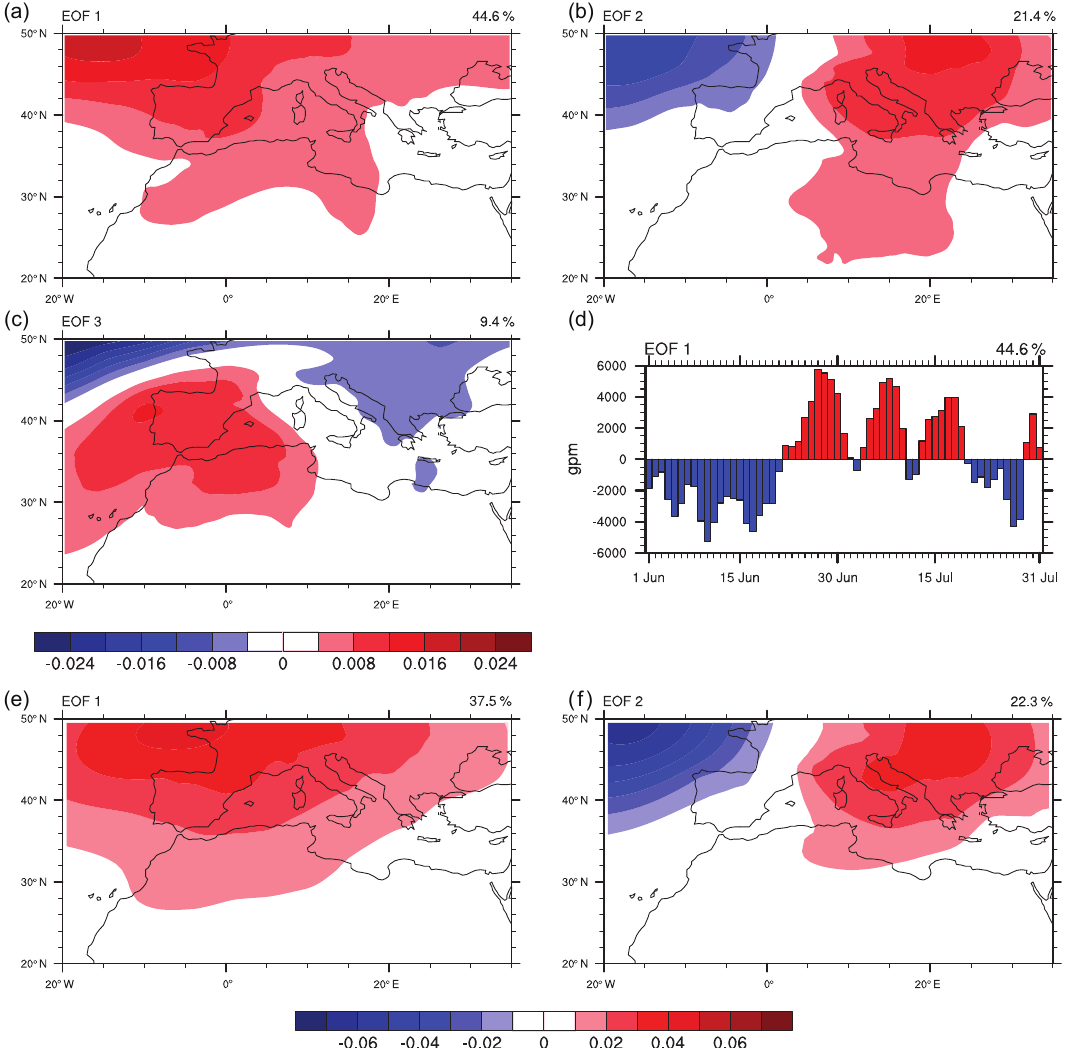
Figure 4. EOF analysis of the 00:00UTC geopotential height at 850hPa taken from COSMO-MUSCAT simulations for June and July 2013. Shown are the first three EOFs and the principal component of the first EOF. The variance explained is given in percentage (upper right corner of each plot). Negative phase: 1–21 June, 3 July, 11–12 July, 20–28 July 2013. Positive phase: 22 June–2 July, 4–10 July, 13–19 July, 29–31 July 2013. Panels (e) and (f) show the first and second EOF, respectively, calculated from ERA-Interim 00:00UTC geopotential heights at 850hPa for June and July